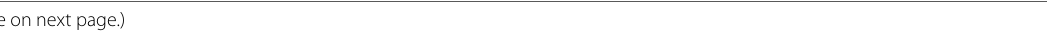
Fig. 2 Colony PCR analysis of replaced sub-regions of Chr2-6 region. Each lane represents checking of left or right edge replacement of Chr2-6 sub-regions in independent transformants (T1, T2, T3, T4, T5 and T6). M represents size marker (Gene Ladder Wide 2, Nippon Gene, Toyama, Japan). A common set of primers (SJP 121 and SJP 242) was used in all PCR verification experiments to amplify the 0.67 kb CNE1 gene on Chromosome 1 as an internal control. 1 kb band was the expected band for replacement of either left or right edge of sub-regions. a SJP 118 and SJP 119 were used for checking left edge whereas SJP 127 and SJP 384 were used for checking right edge replacement of A1 A2 sub-regions, respectively. b SJP 390 + and SJP 119 were used for checking left edge whereas SJP 127 and SJP 385 were used for checking right edge replacement of B1 B2 sub-regions, + respectively. c SJP 118 and SJP 119 were used for checking left edge whereas SJP 127 and SJP 457 were used for checking right edge replacement of A1 A2 B1 sub-regions, respectively. d SJP 427 and SJP 119 were used for checking left edge whereas SJP 127 and SJP 385 were used for + + checking right edge replacement of A2 B1 B2 sub-regions, respectively. e SJP 118 and SJP 119 were used for checking left edge whereas SJP + + 127 and SJP 479 were used for checking right edge replacement of A1 A2 B1 (Ex) sub-regions, respectively. f SJP 483 and SJP 119 were used for + + checking left edge whereas SJP 127 and SJP 385 were used for checking right edge replacement of A2 (Ex) B1 B2 sub-regions, respectively. g + + SJP 118 and SJP 119 were used for checking left edge whereas SJP 127 and SJP 385 were used for checking right edge replacement of entire Chr2-6